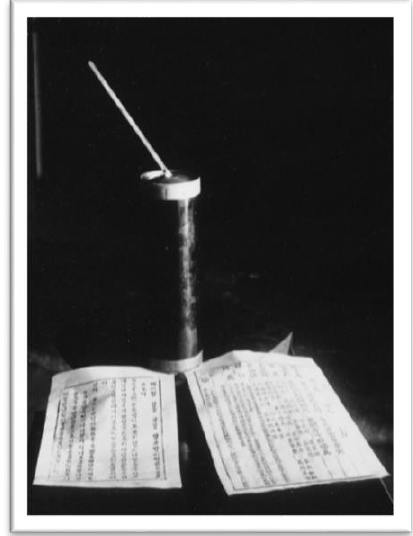
Figure 9. Numinous Lots at the East Shrine (No. 1027-1, National Museum of Korea).